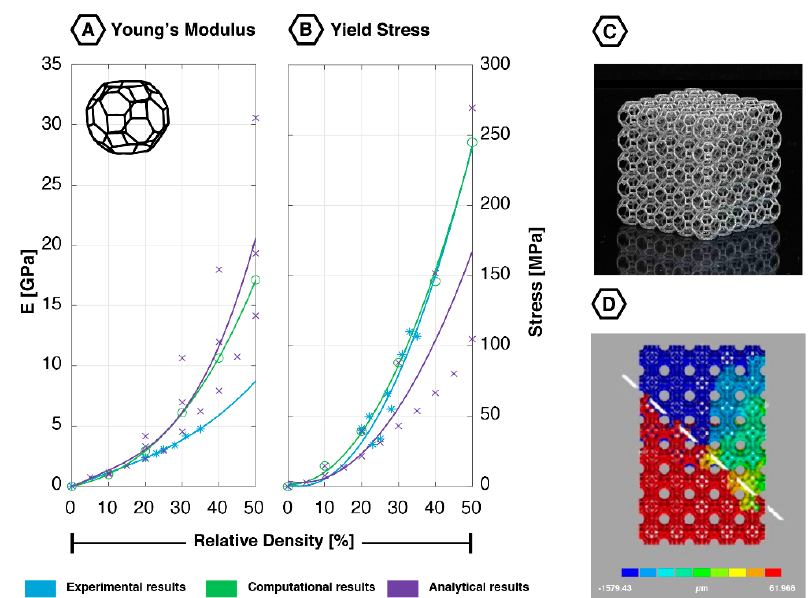
Figure 5. Mechanical properties of the truncated cuboctahedron unit cell based on experimental, computational, and analytical data: ( A ) Young’s modulus [18,19,21]; ( B ) yield stress [12,18,19,21,60]; ( C ) additively manufactured truncated cuboctahedron lattice (5 × 5 × 5 unit cells); ( D ) fatigue failure surface (45-degree shear band) showing the deformation in the loading direction; reprinted with permission from Ref. [20] © 2016 Elsevier.